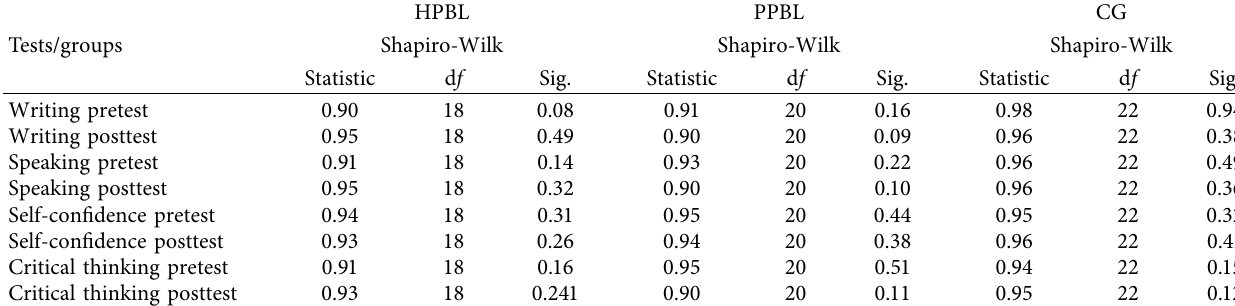
Table 2: Results of Shapiro-Wilk test of normality.